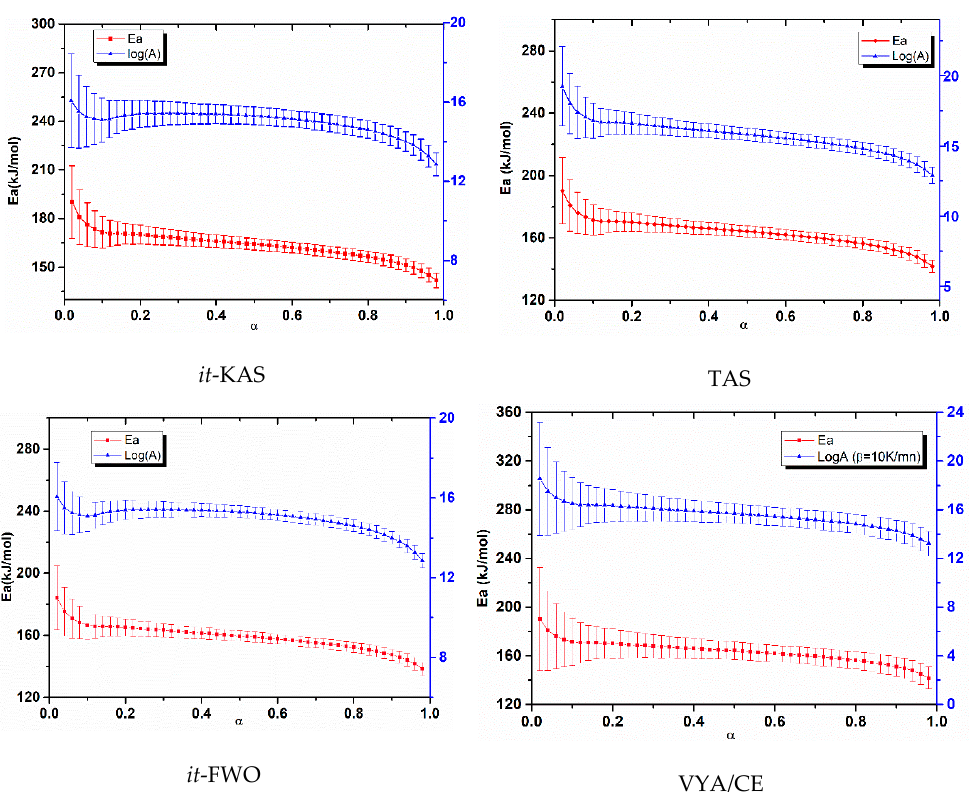
Figure 7. Arrhenius parameters and their associated confidence intervals evolution with respect to α determined by the different kinetic methods for NC-Fe 2 O 3 - CMS .